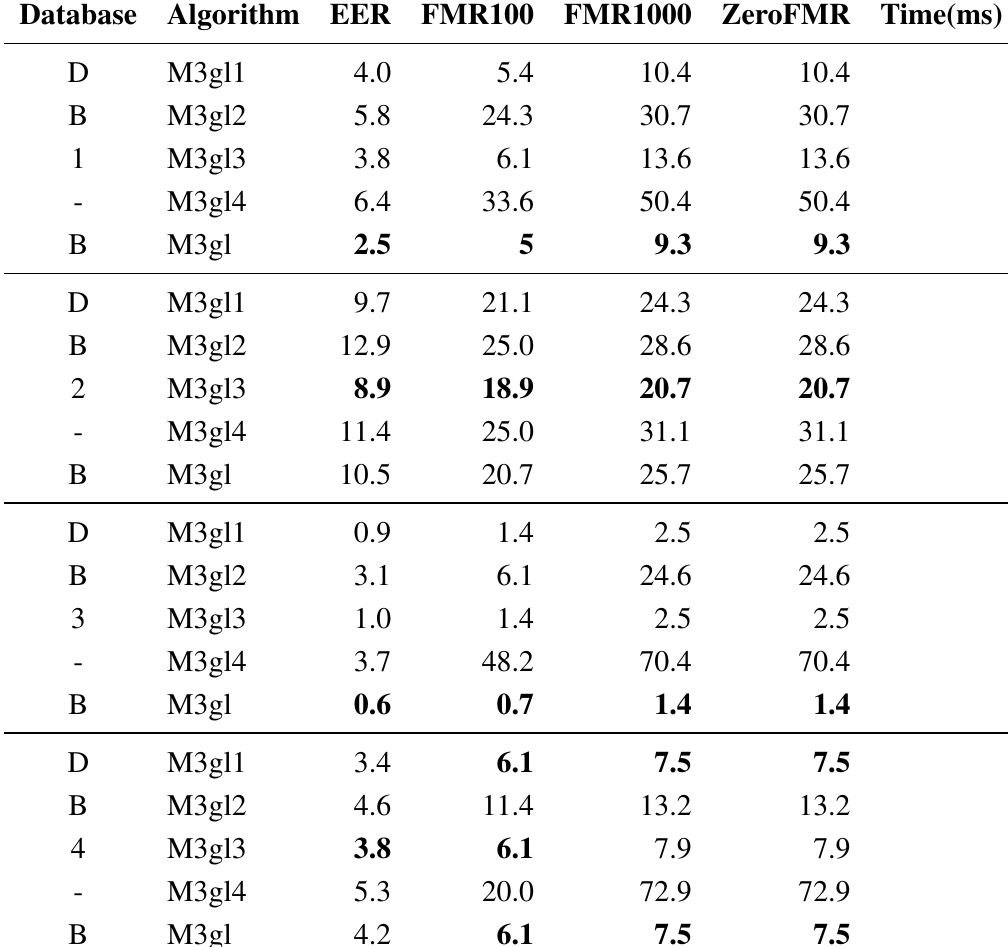
Experimental results on databases DB1 B, DB2 B, DB3 B and DB4 B of